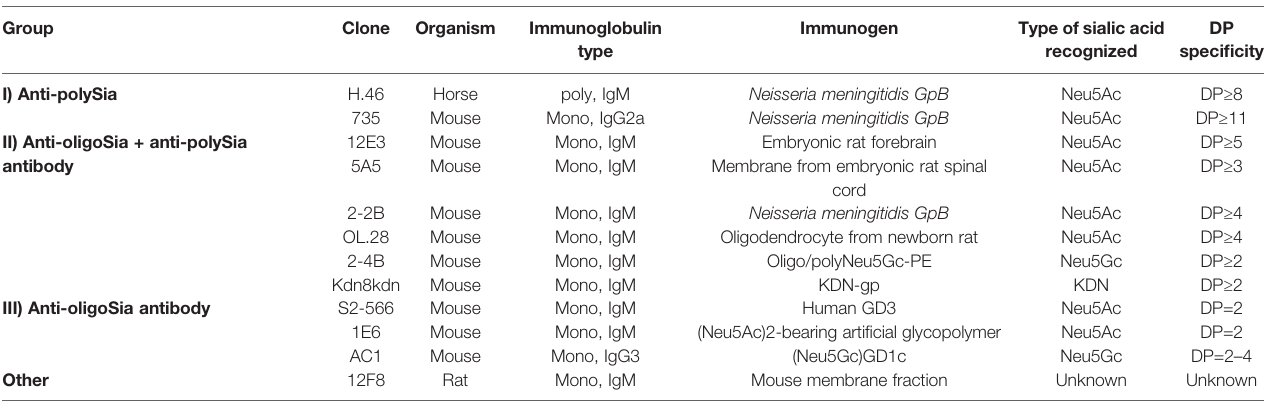
TABLE 4 | Anti-oligoSia/polySia antibodies.